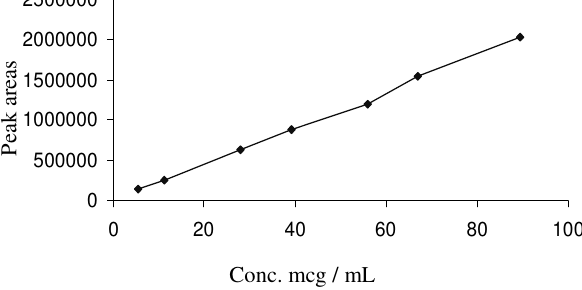
Figure 2. Calibration curve of levetiracetam by